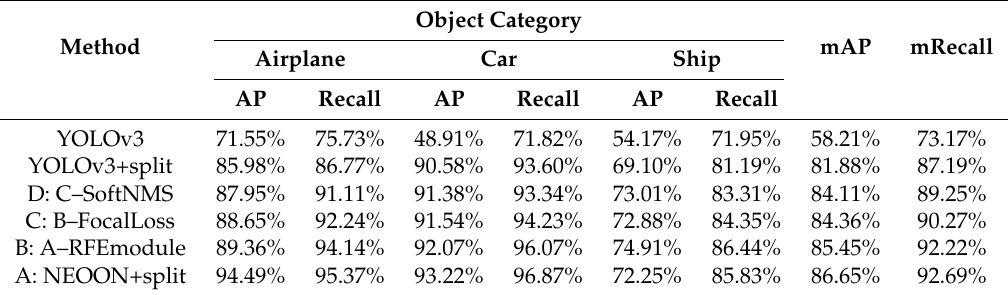
Table 2. Comparison of performance on ACS